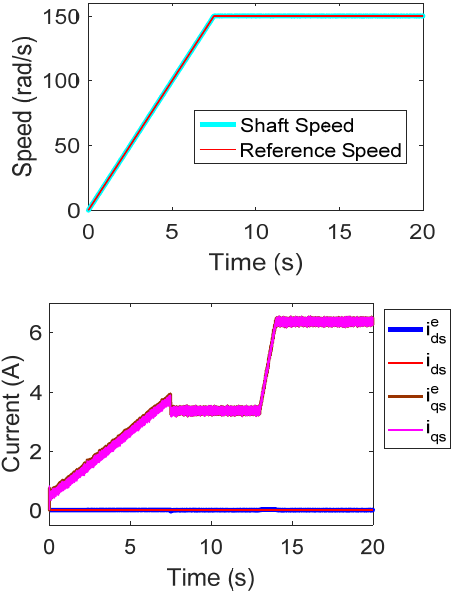
Figure 15 . Experimental results for the high-speed operation. Figure 15. Experimental results for the high-speed